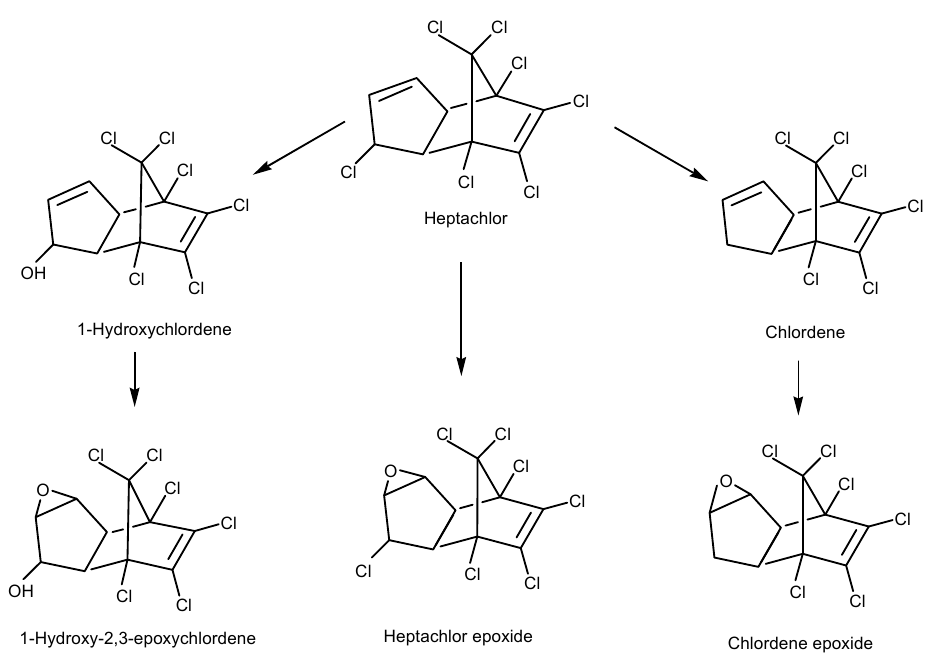
Figure 7. Metabolic pathway of heptachlor through fungal degradation [167,211].